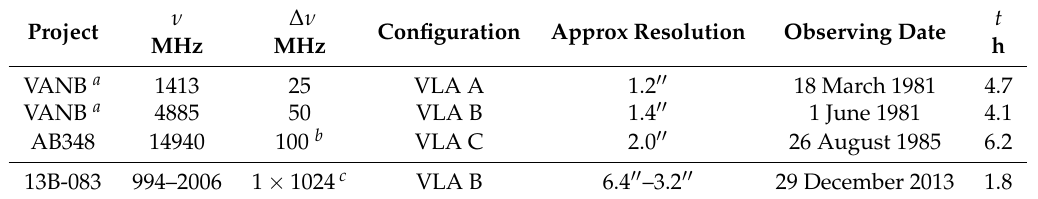
Table 1. Table outlining the VLA observations of Coma A. ν is the observing frequency. The bandwidth is ∆ ν and t is the total integration time on Coma A. The single horizontal line separates the archival VLA from the Jansky Very Large Array (JVLA) data.